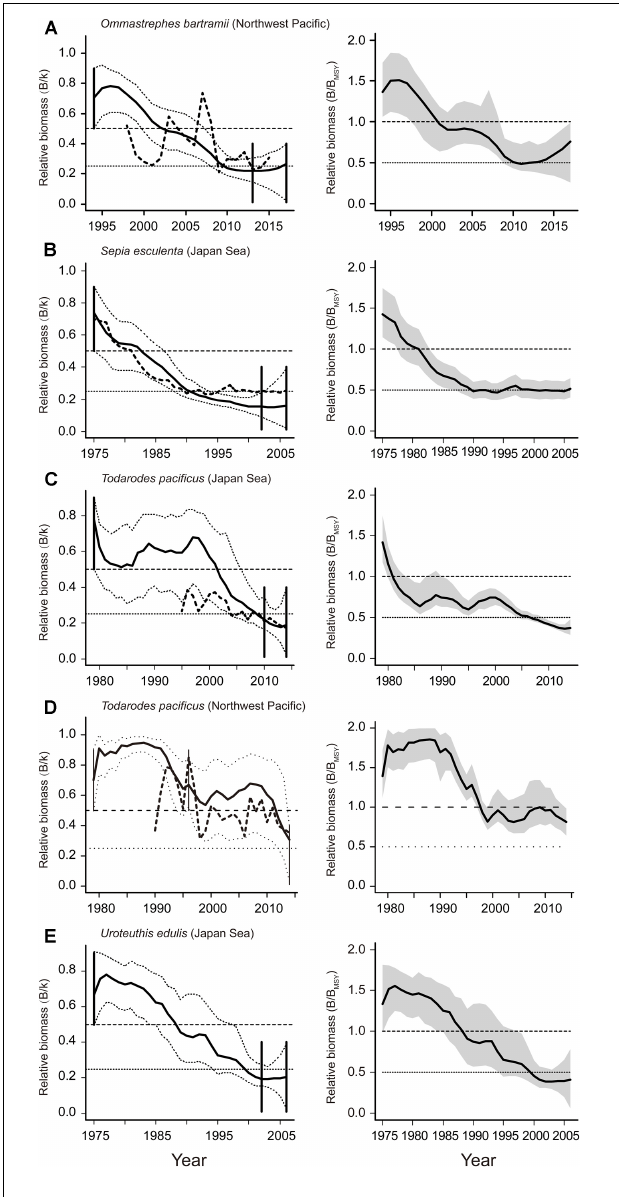
FIGURE 3 | Estimated biomass and the development of relative biomass of 5 stocks assessed ( A–C in BSM, D,E in CMSY). Estimated biomass trajectories (left panels) from CPUE by BSM (bold dashed line) and catch by CMSY (bold solid line), with the 95% confidence limits (dashed lines), and vertical lines represented the prior biomass ranges. The trajectories of relative total biomass ( B/B MSY ) are shown (right panel) with the gray areas indicating uncertainty.